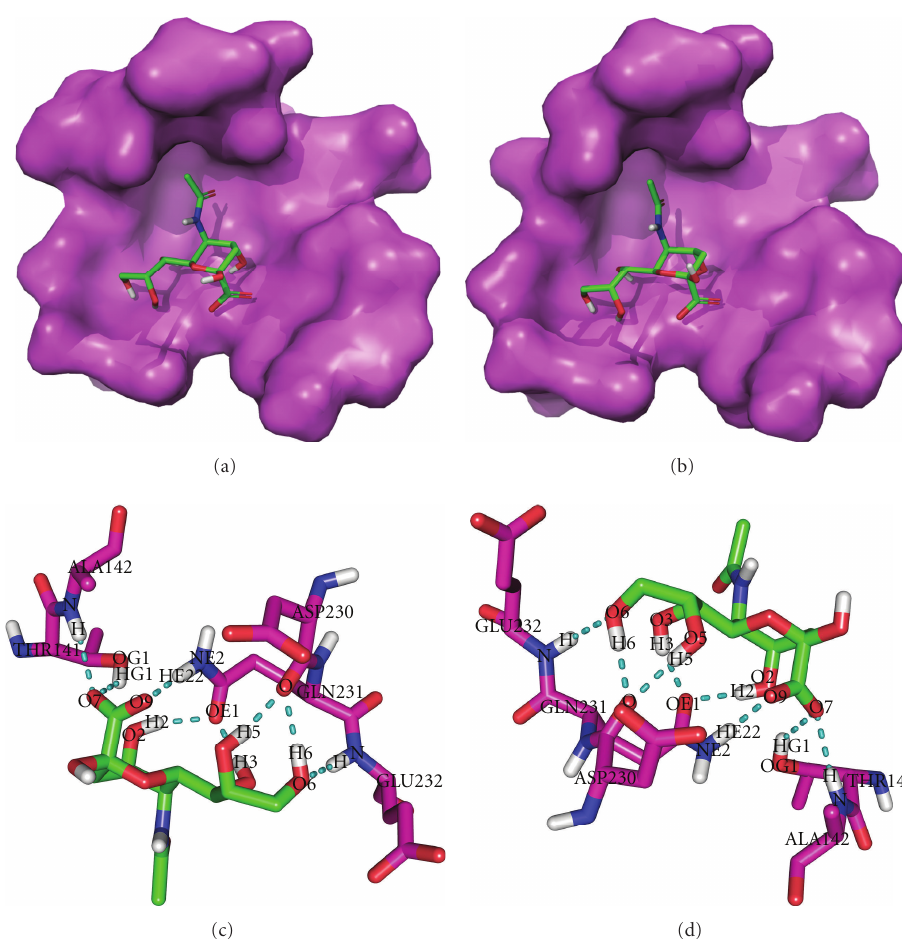
Figure 4: (a) Docking of Beta-Sialic acid on molecular surface of HA protein by Schrodinger, (b) docking of O-Sialic acid on molecular surface of HA protein by Schrodinger; (c) interaction of B-Sialic acid with HA protein by hydrogen-bond, and (d) interaction of O-Sialic acid with HA protein by